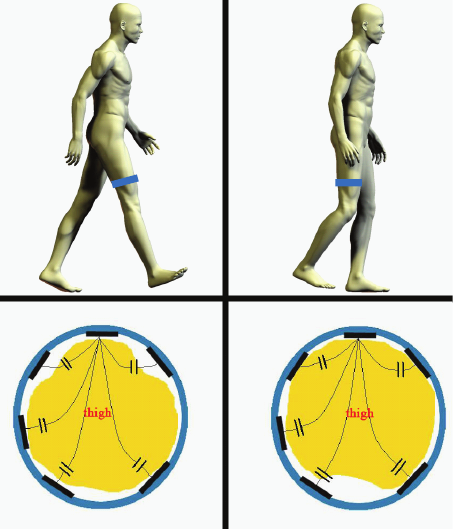
Figure 3. The sensing principle of lower limb movement detection based on our